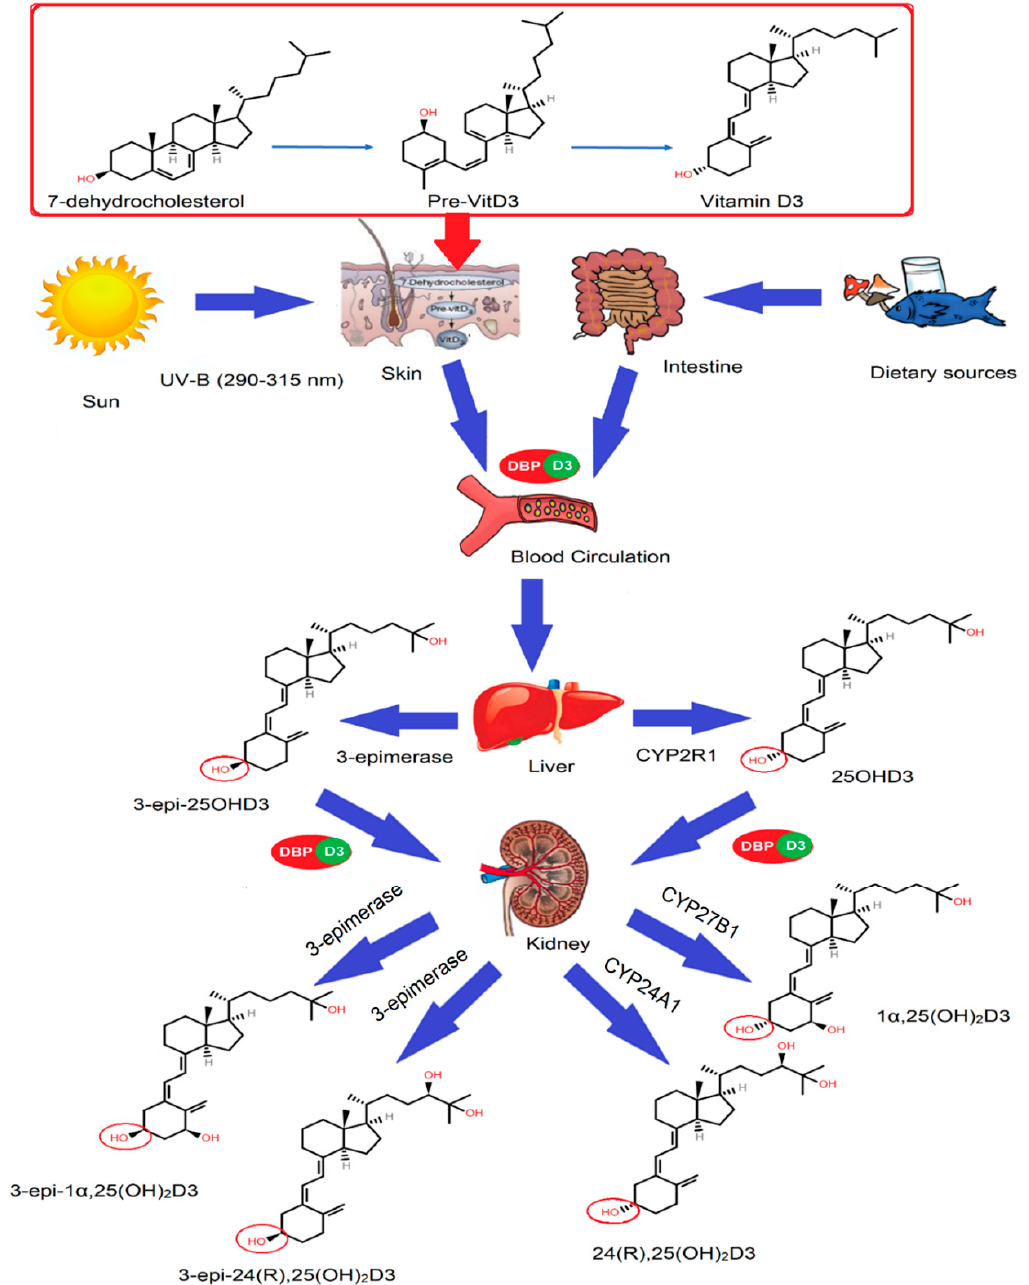
Figure 1. Sources and metabolism of vitamin D. Sunshine activates a chemical reaction in the plasma membrane of dermal fibroblasts and epidermal keratinocytes in the skin, producing an unstable form, 7-dehydrocholesterol, which forms pre-vitamin D3 and, upon thermal isomerization, produces a stable vitamin D3 form. Dietary sources are another source of vitamin D3 and D2. Hydroxylation of vitamin D3 occurs in the liver using enzyme CYP2R1, mainly forming 25OHD3. In the kidney, 25OHD3 undergoes further hydroxylation at the C-1 α or C-24 positions. The CYP27B1 enzyme is responsible for C-1 α hydroxylation, while CYP24A1 is responsible for C-24 hydroxylation. CYP24A1 can inactivate 25OHD3 to produce 24R,25(OH) 2 D3, while 3-epimerase enzyme could inactivate the major metabolites (25OHD3, 24R,25(OH) 2 D3, and 1 α ,25(OH) 2 D3) in the epimerization process by changing the orientation of only one group.